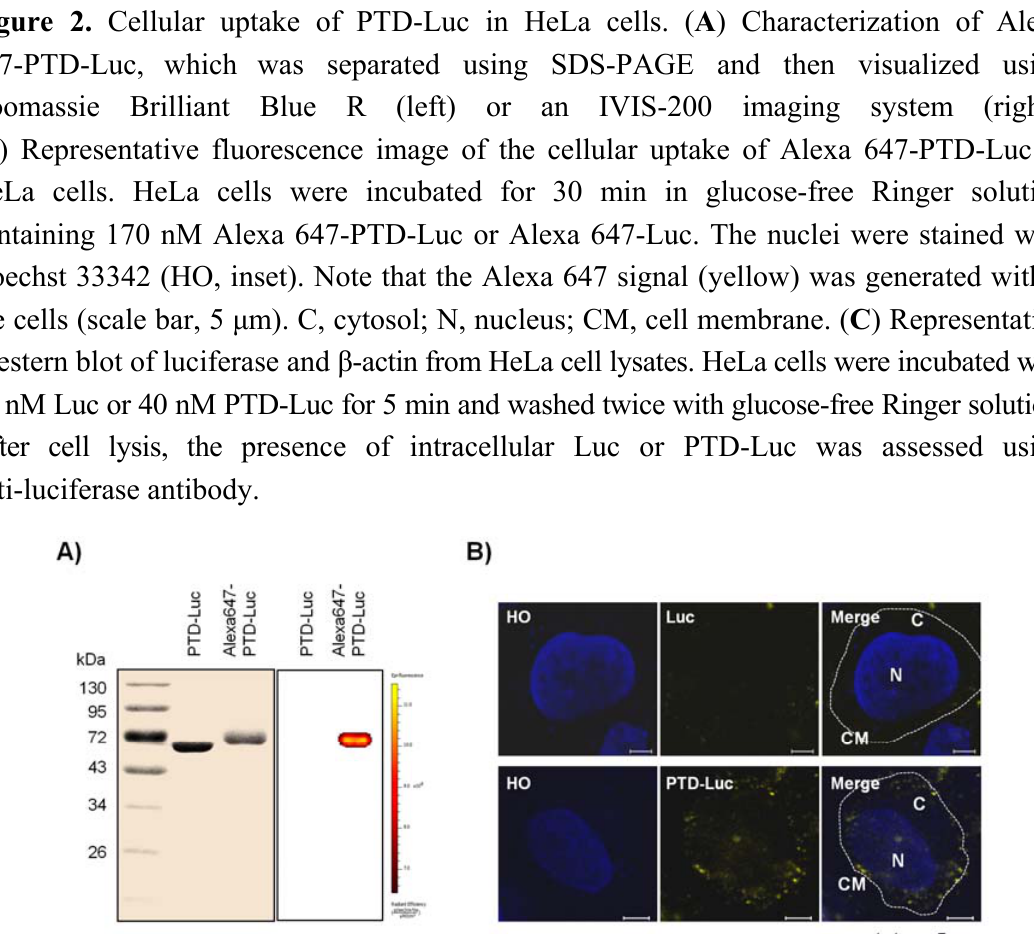
Figure 2. Cellular uptake of PTD-Luc in HeLa cells. ( A ) Characterization of Alexa 647-PTD-Luc, which was separated using SDS-PAGE and then visualized using Coomassie Brilliant Blue R (left) or an IVIS-200 imaging system